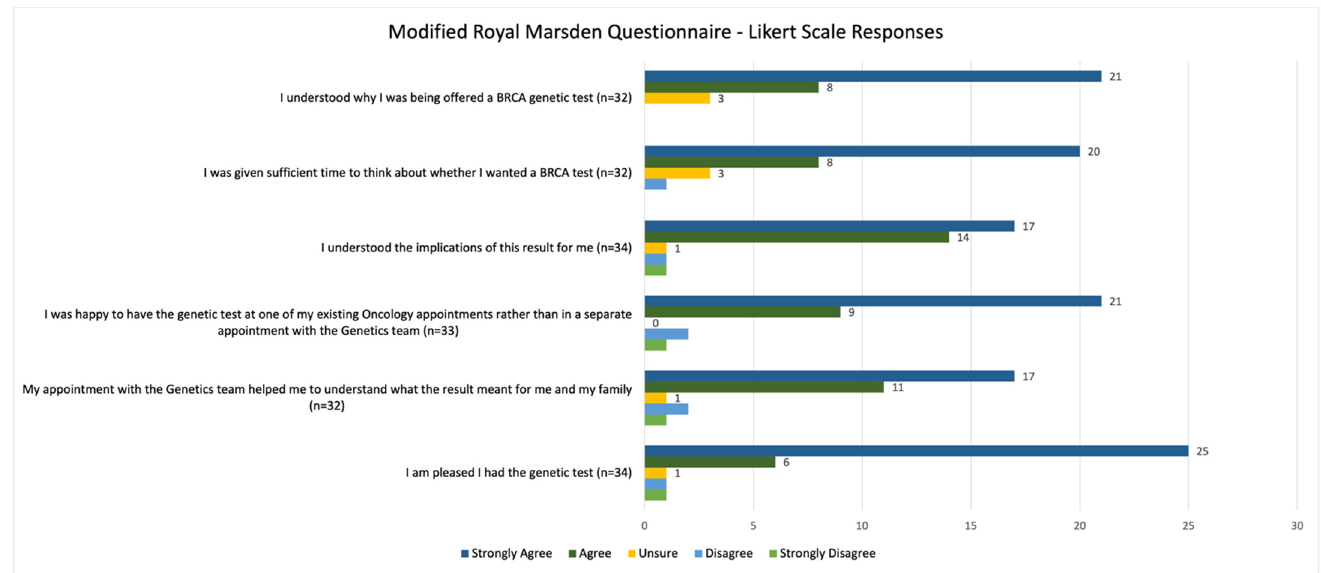
Figure 3. Summary of patient responses to Likert-scale questions from the modified Royal Marsden Patient Satisfaction questionnaire.